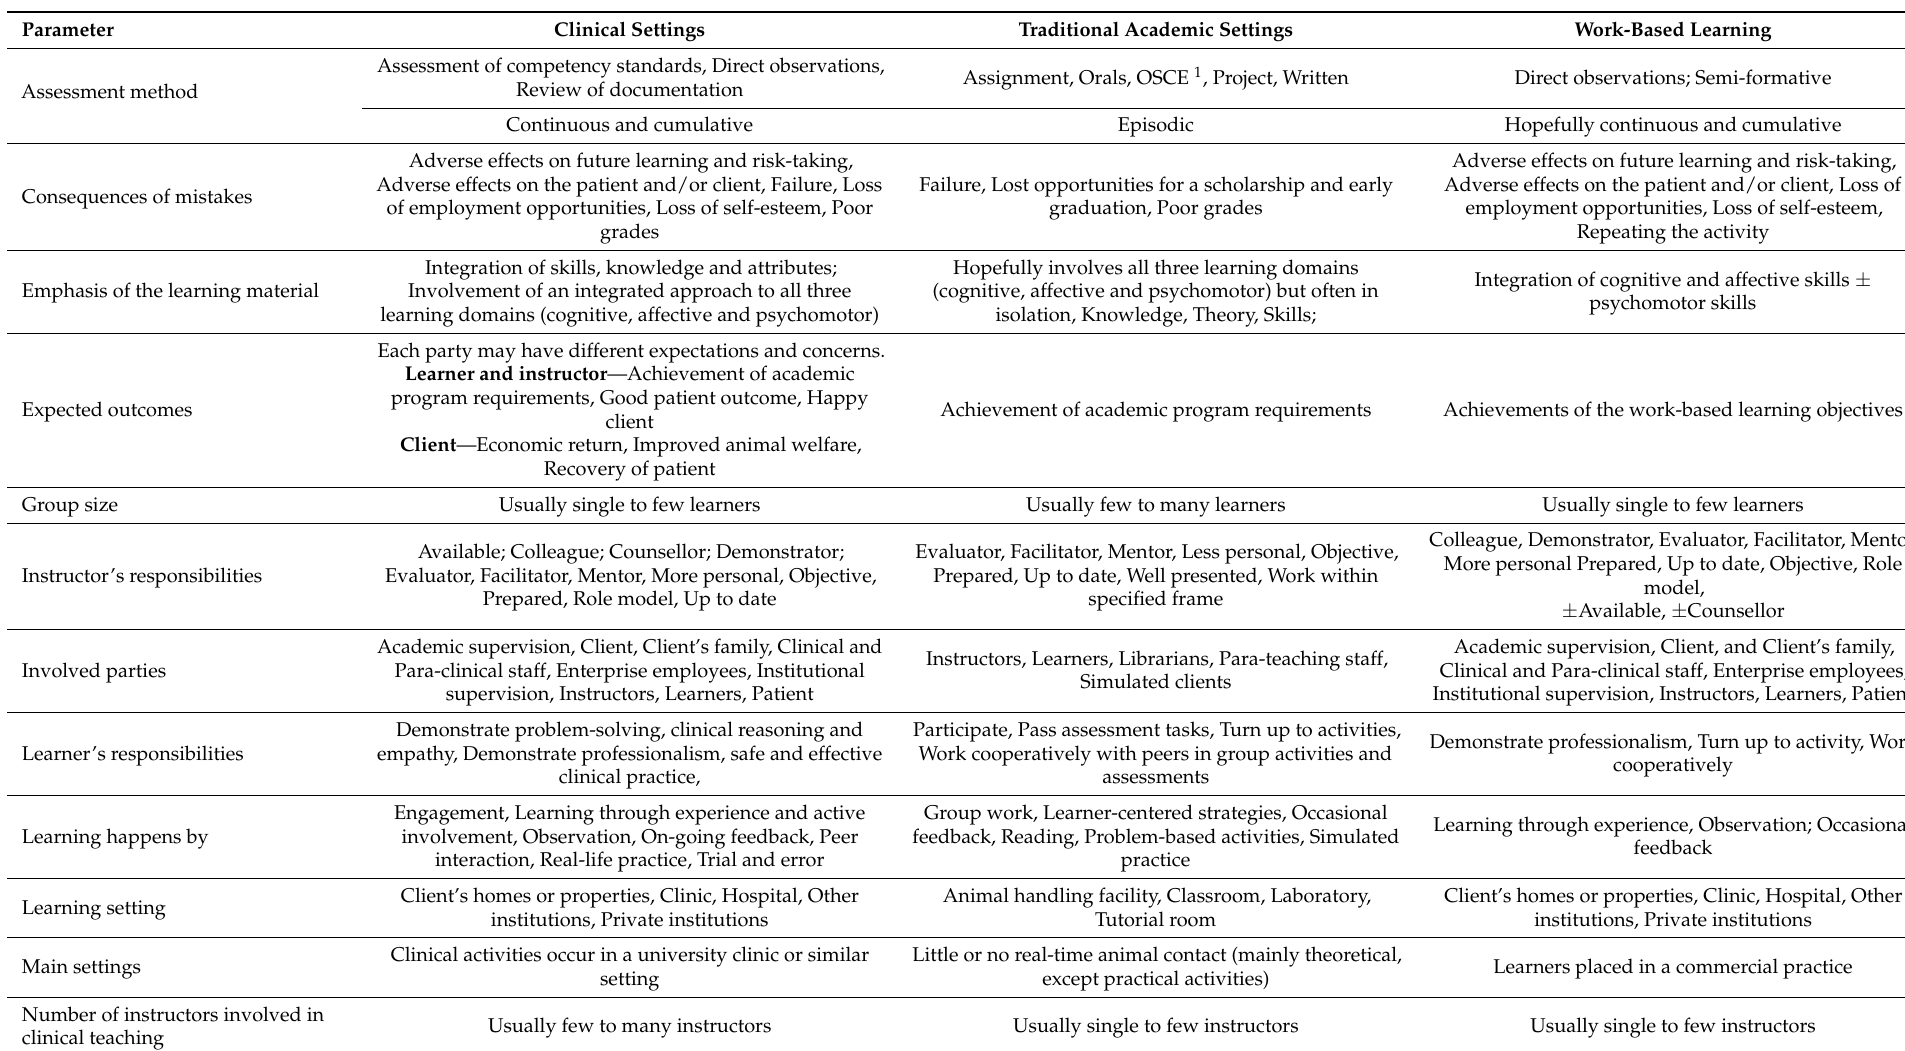
Table 1. Differences between clinical teaching settings on learner assessment and learning outcomes. Bolded text—difference between